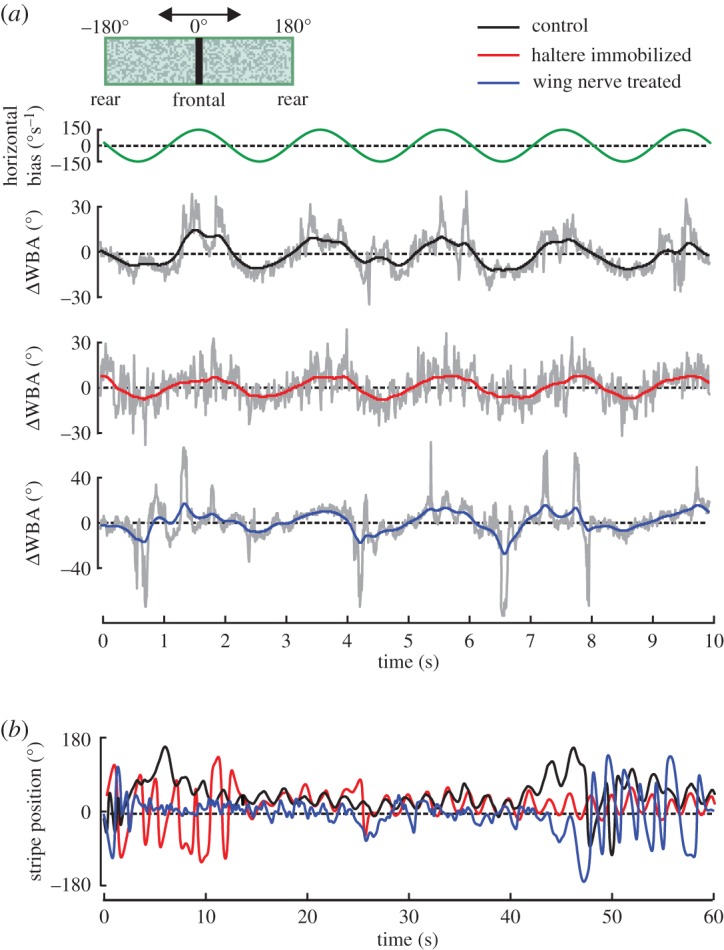
Typical examples of object fixation response in tethered fruit flies. (a) Horizontal velocity bias applied to stripe motion (top), difference between left and right wingbeat amplitude (ΔWBA, lower traces) and (b) instantaneous stripe position during object fixation in single flies. Black, intact controls; red, haltere-immobilized flies; blue, wing nerve treated flies. Grey lines show raw data, coloured traces are filtered using a first order Butterworth low pass filter with 1 Hz cut-off frequency. Aerodynamic damping coefficient was 520 pNms and inset shows visual pattern.